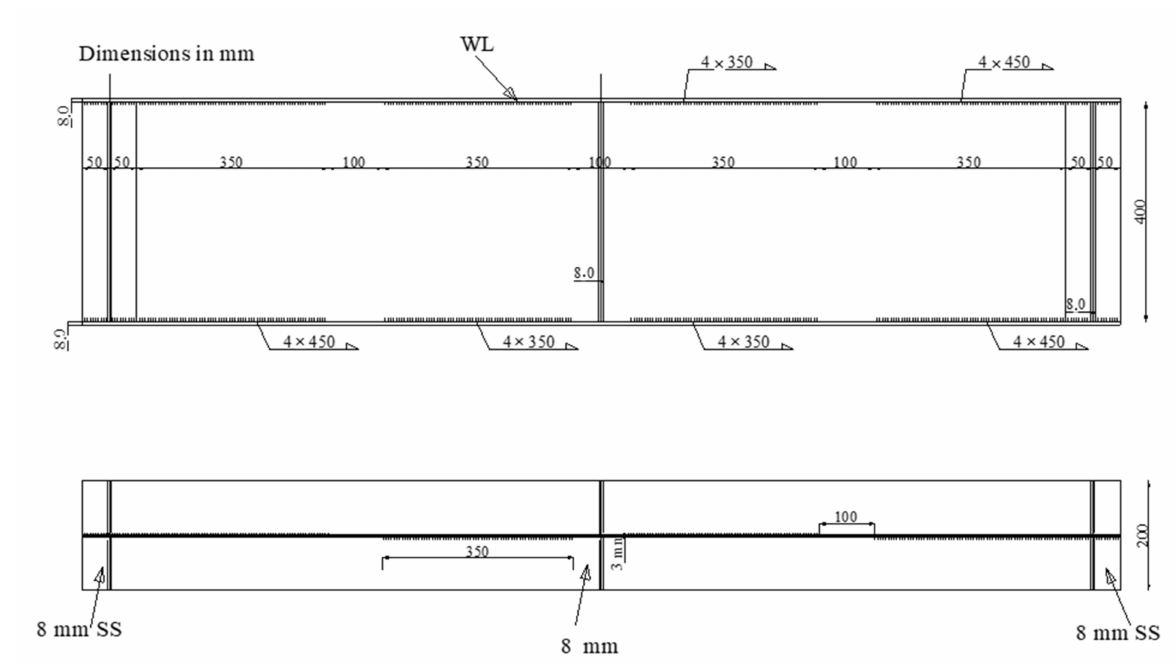
Figure 5. Flat-web specimen-intermittent welding line (FW35WL).